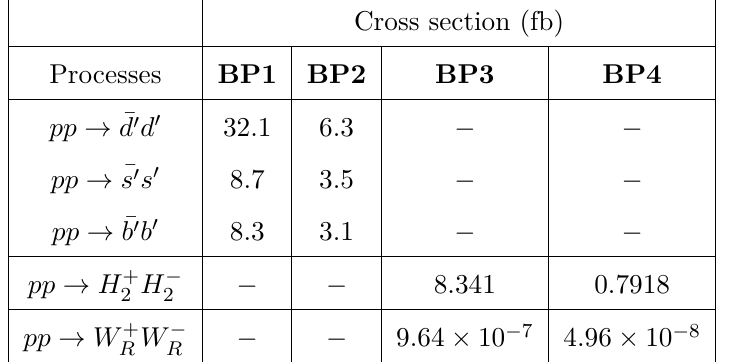
masses of right-handed gauge bosons and the other heavy scalars corresponding to the above BP ’s are listed in table 7. The choice for the masses of new particles such that the DM candidates (the lightest scalar and/or pseudo-scalar and the scotinos) in the